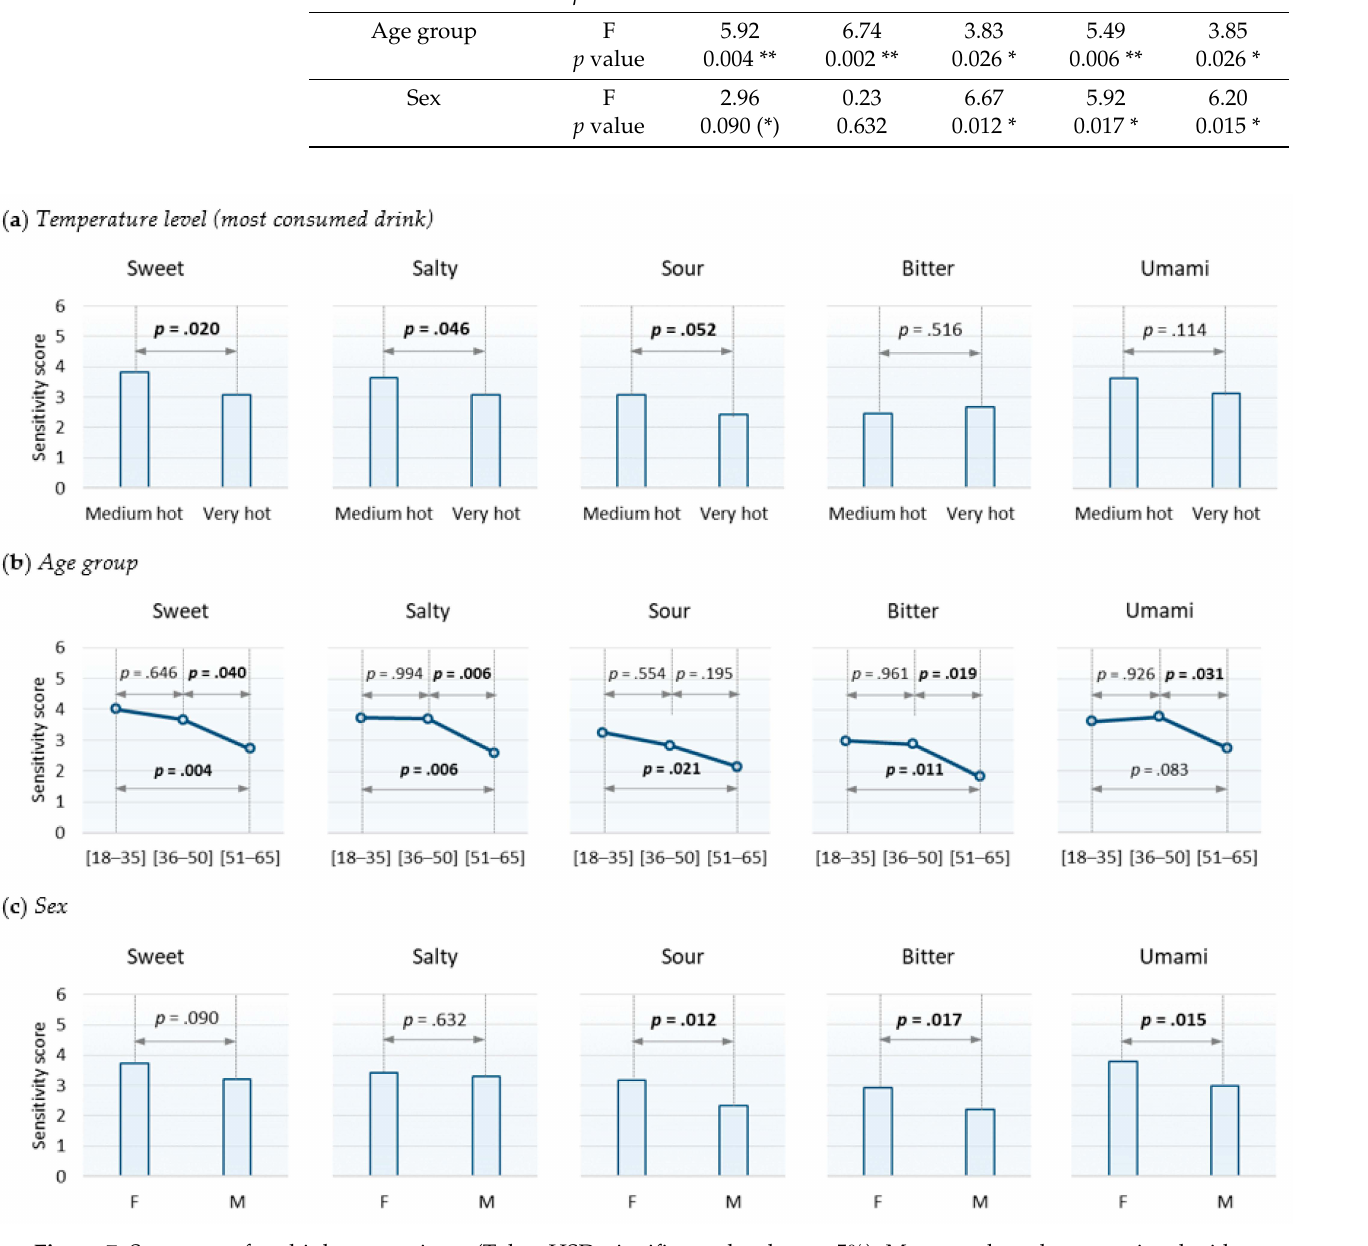
Figure 7. Summary of multiple comparisons (Tukey HSD; significance level set at 5%). Means and p values associated with Tukey’s results. The p values in bold are less than or equal to